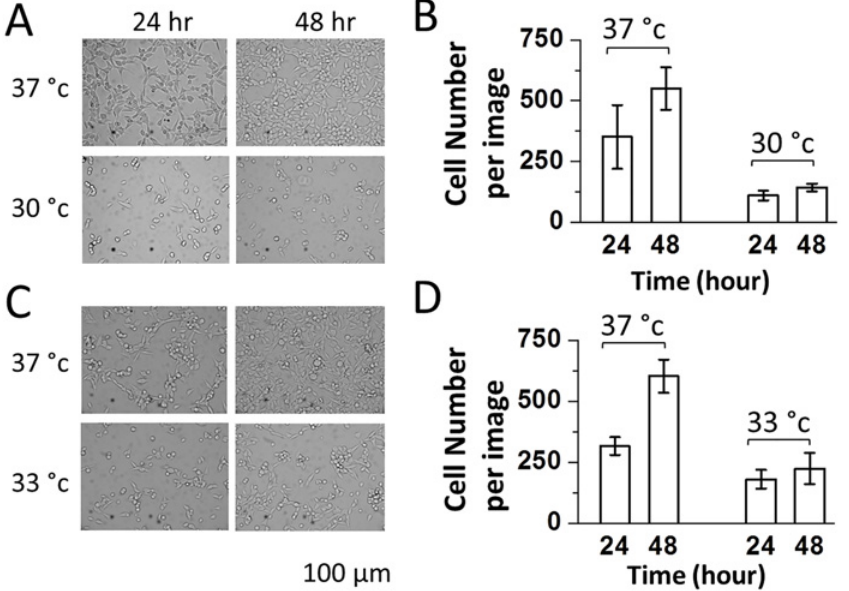
Fig 1. Bright-field images (34.8x magnification) of HEK-293S cells growing at 37°C (upper A and C), 30°C (lower A), and 33°C (lower C). HEK-293S cells were seeded at a density of 5.5 x 10 5 cells/35 mm Petri dish. The images were taken at 24 and 48 hours using a digital camera mounted on a Carl Zeiss Axiovert S200 microscope (see Methods). Cell number counts per image or 0.22 mm 2 were plotted in (B) and (D) based on the images shown in (A) and (C), respectively. For each dish, 3 viewing areas were randomly chosen and their images were taken.